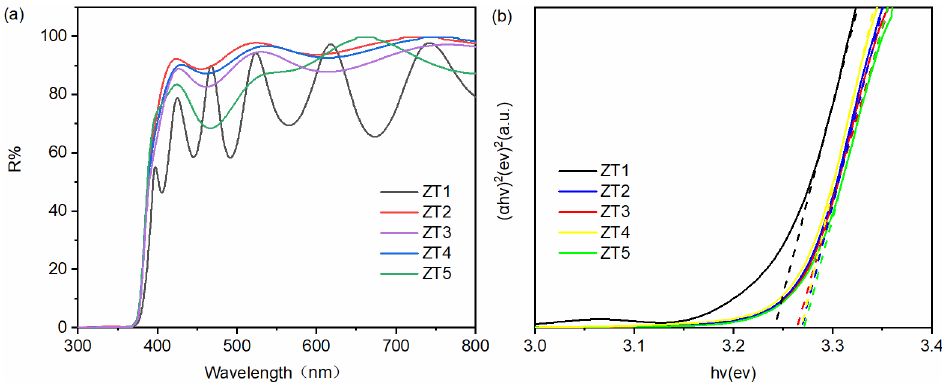
Figure 7. The transmittance ( a ) and the bandgap values ( b ) of the ZT1, ZT2, ZT3, ZT4, and ZT5.